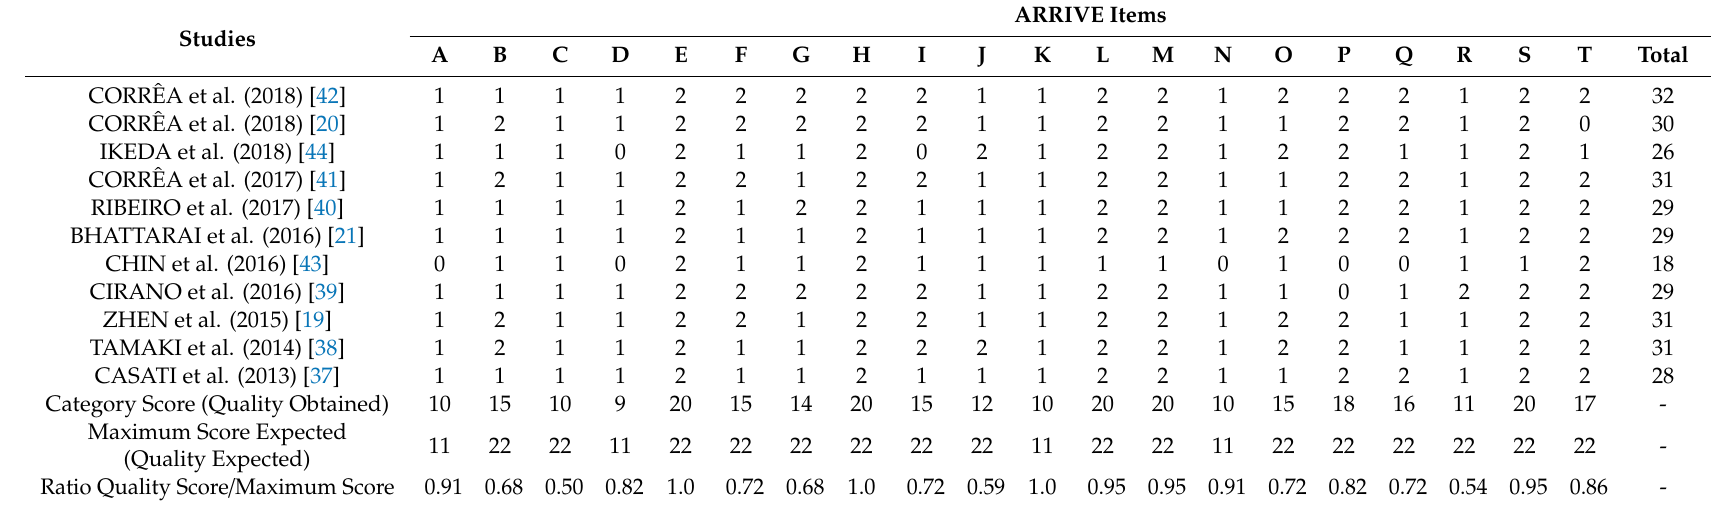
Table 4. The scores of the quality assessment according the Animal Research Reporting In Vivo Experiment (ARRIVE) guidelines of the included studies.